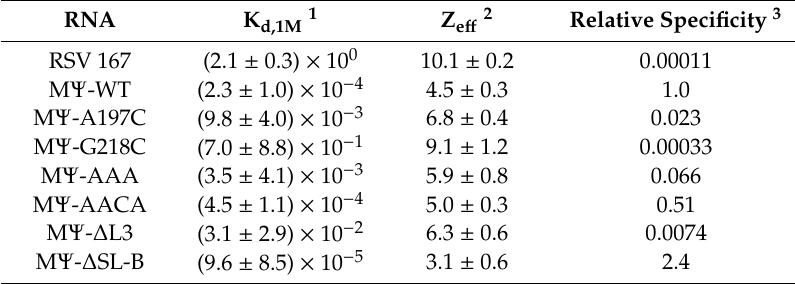
Table 1. K d,1M and Z e ff values determined by FA salt titration binding assays of RSV Gag ∆ PR with RSV 167, M Ψ -WT and six M Ψ